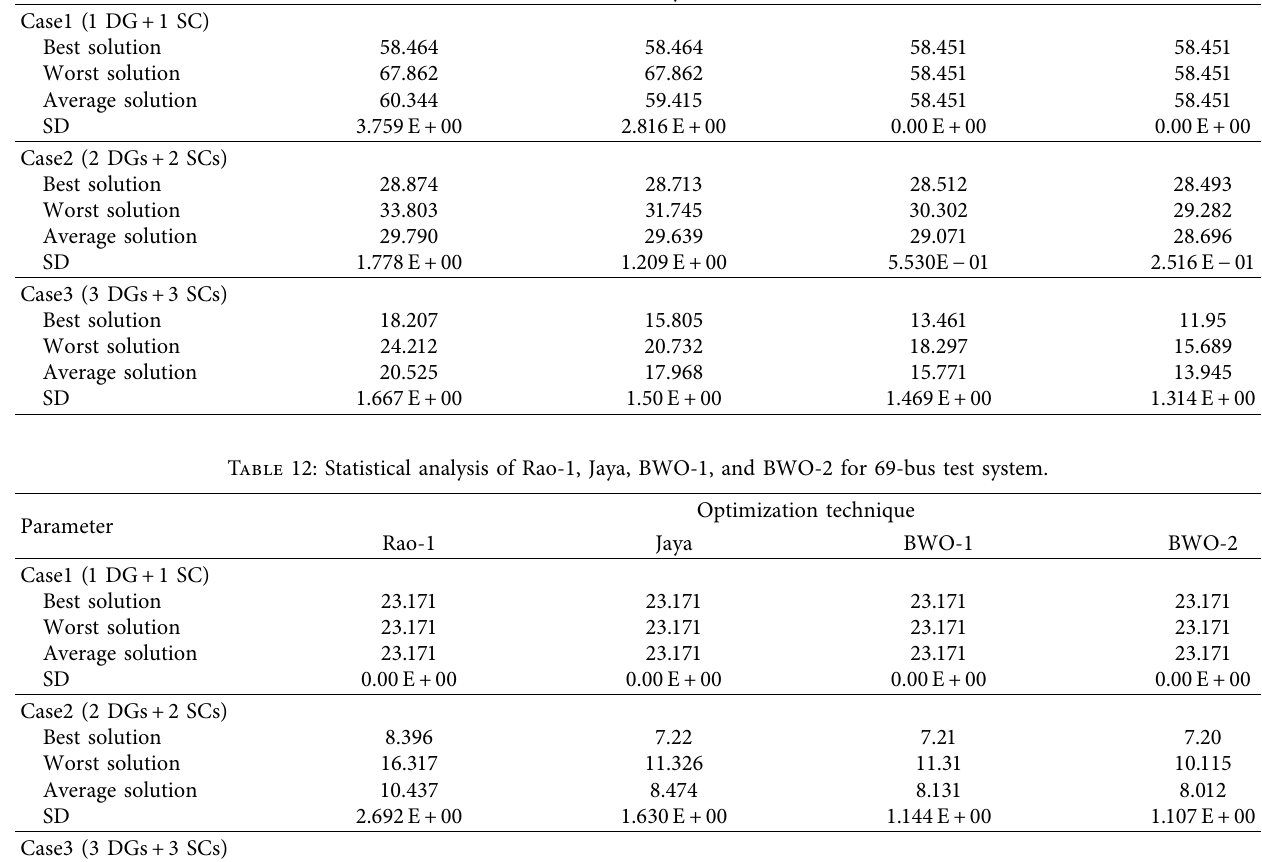
Table 11: Statistical analysis of Rao-1, Jaya, BWO-1, and BWO-2 for 33-bus test system.